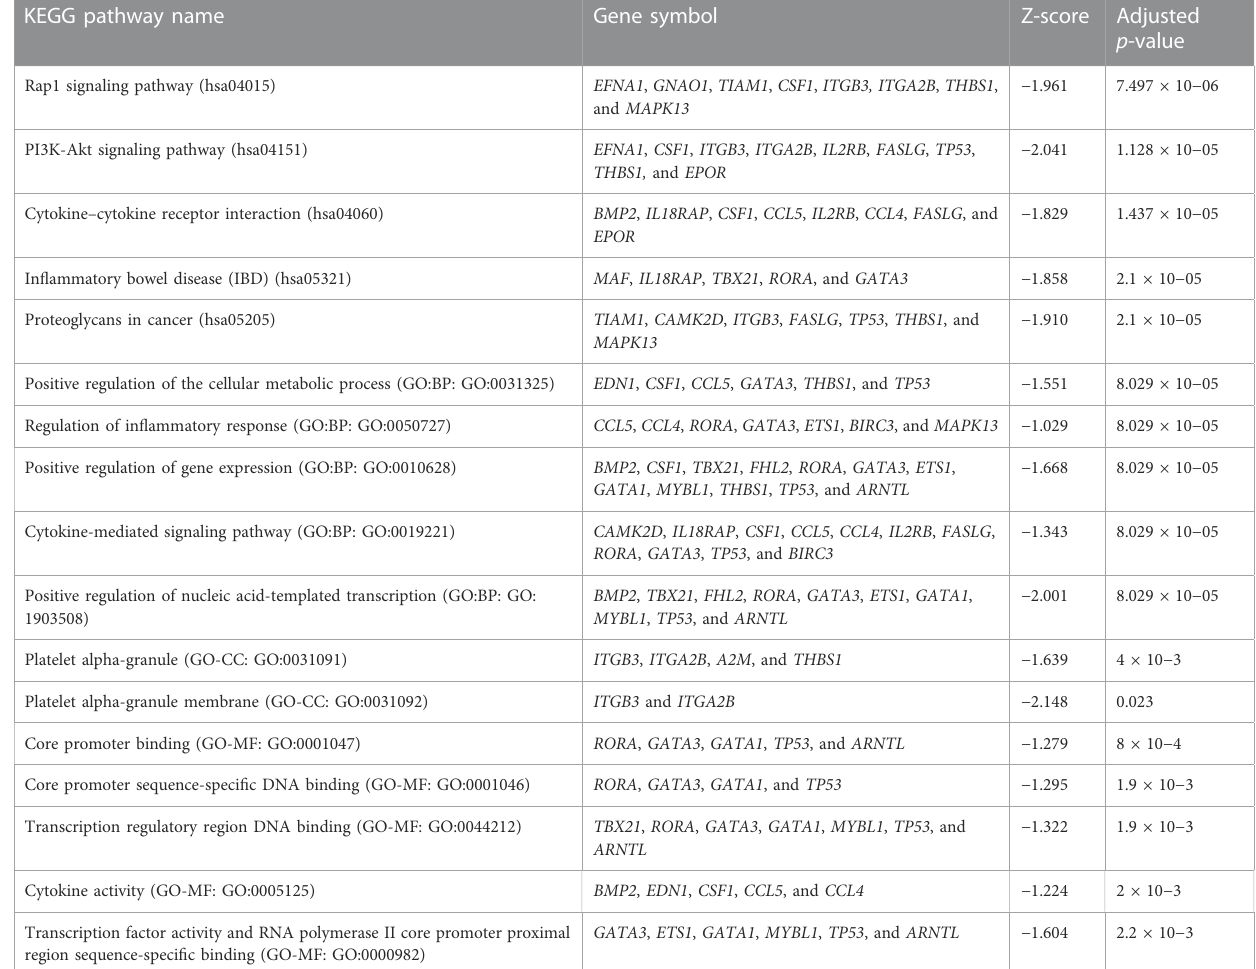
TABLE 5 Top fi ve signi fi cant KEGG pathways and Gene Ontology (GO) terms* for the gene set belonging to the LAML signature. KEGG pathway